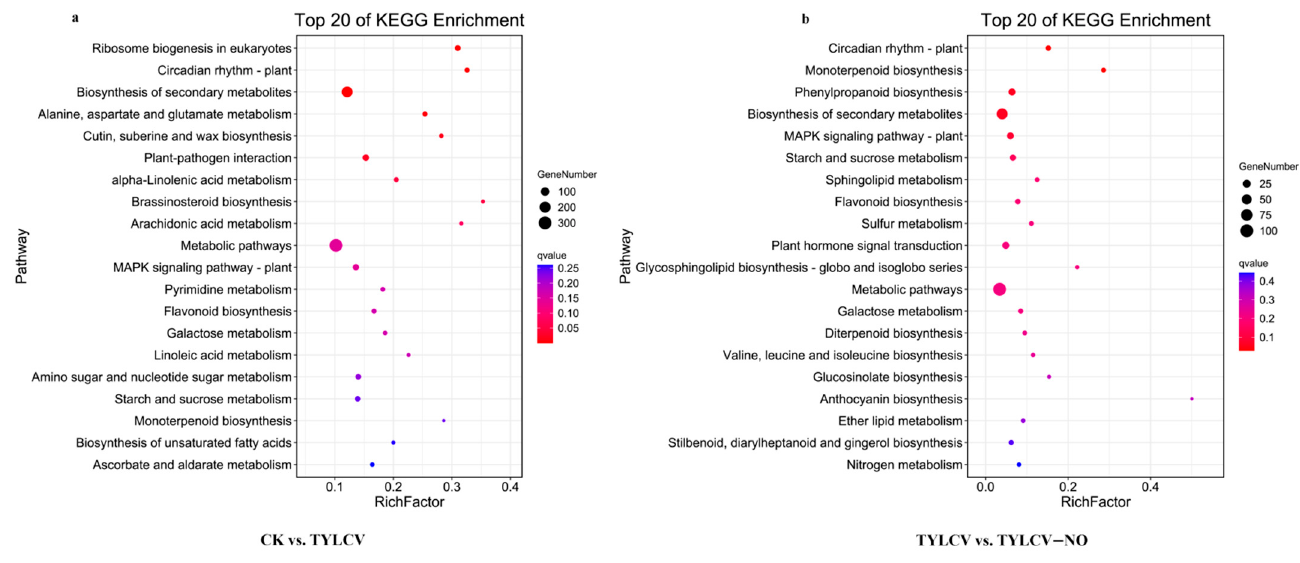
Figure 4. KEGG enrichment analysis of DEGs in tomato leaf responsive to TYLCV and exogenous NO in susceptible tomato. ( a ) KEGG enrichment analysis of negative control and positive control producing DEGs. ( b ) KEGG enrichment analysis of DEGs generated in positive control and treat- ment